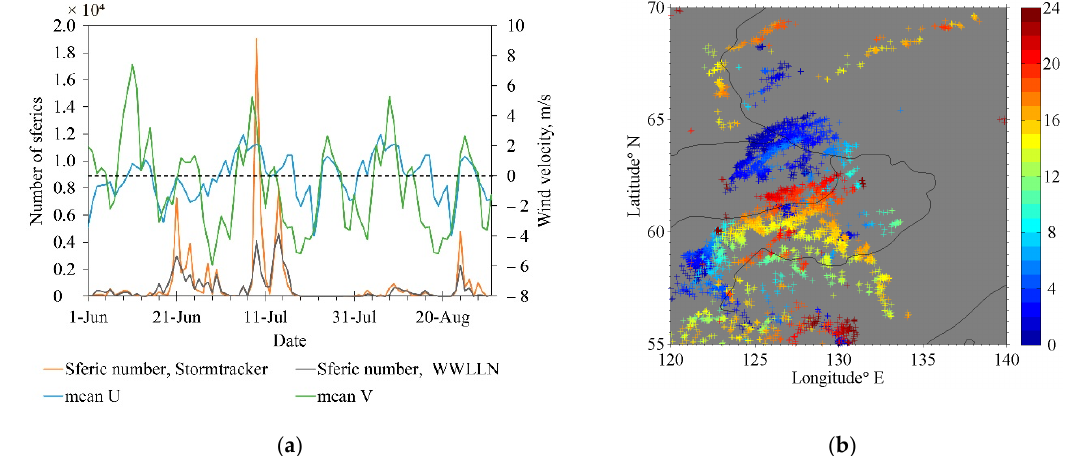
Figure 6. ( a ) The seasonal variation in sferic number within a 480 km radius from Yakutsk with the corresponding average daily values of zonal (U) and meridional (V) components of the wind at 850 hPa and ( b ) the hourly spatial distribution of lightning strokes according to WWLLN on 9 July 2019; the color marks the local time.